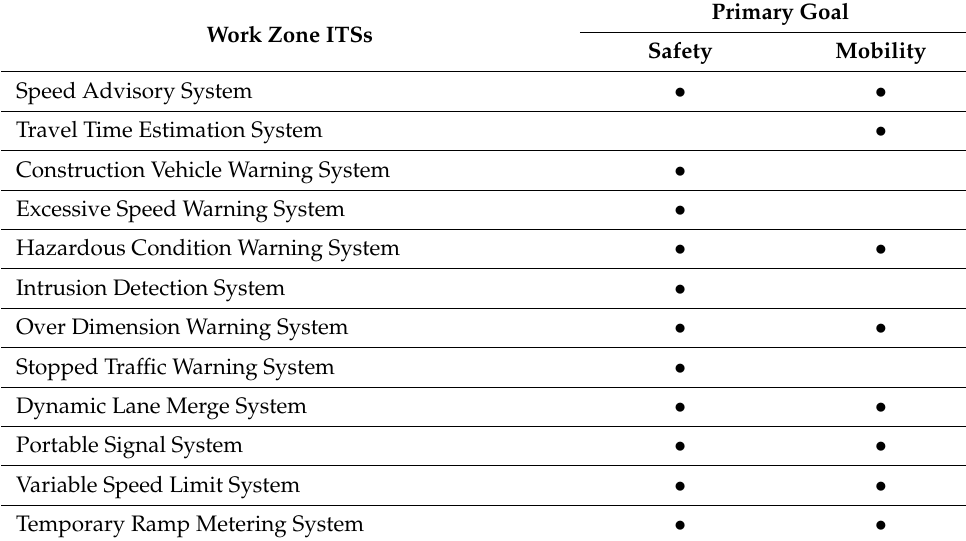
Table 3. Primary goals of the work zone